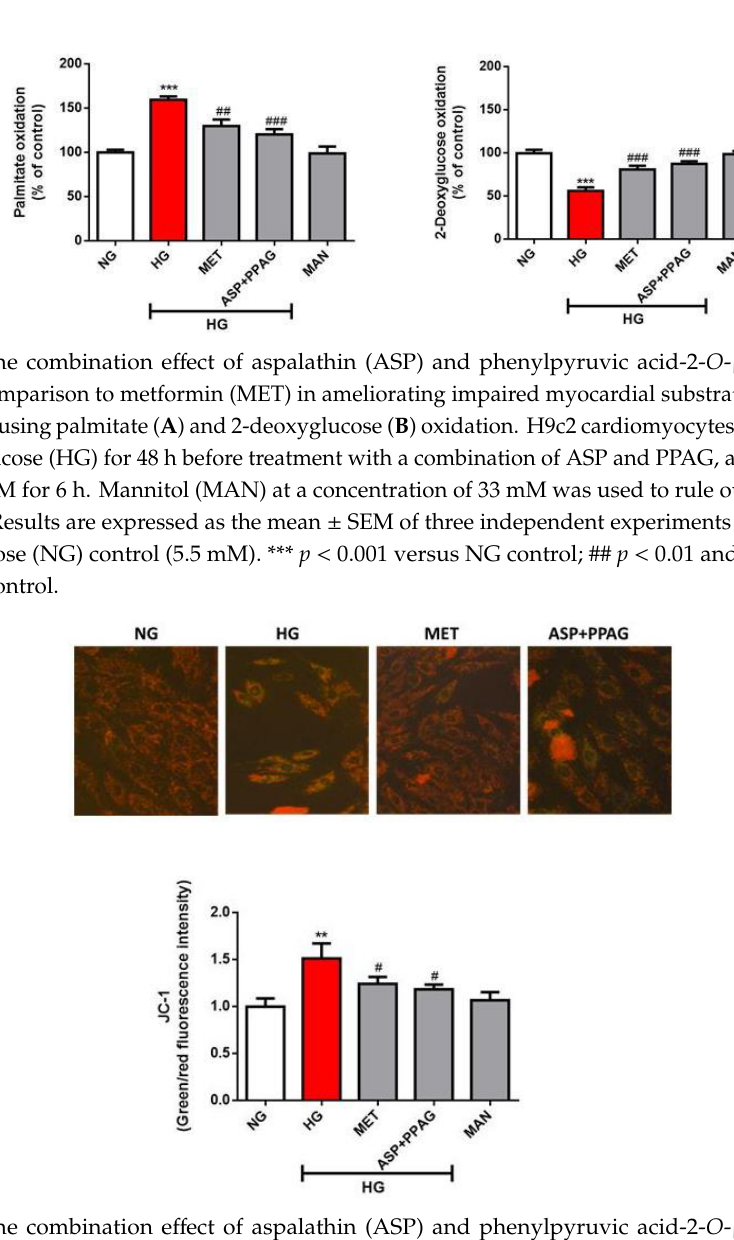
Figure 1. The combination effect of aspalathin (ASP) and phenylpyruvic acid-2- O -β- D -glucoside (PPAG) in comparison to metformin (MET) in ameliorating impaired myocardial substrate metabolism, as measured using palmitate ( A ) and 2-deoxyglucose ( B ) oxidation. H9c2 cardiomyocytes were exposed to 33 mM glucose (HG) for 48 h before treatment with a combination of ASP and PPAG, as well as MET, at a dose 1 μM for 6 h. Mannitol (MAN) at a concentration of 33 mM was used to rule out the effect of osmolarity. Results are expressed as the mean ± SEM of three independent experiments relative to the normal glucose (NG) control (5.5 mM). *** p < 0.001 versus NG control; ## p < 0.01 and ### p < 0.001 versus HG control.